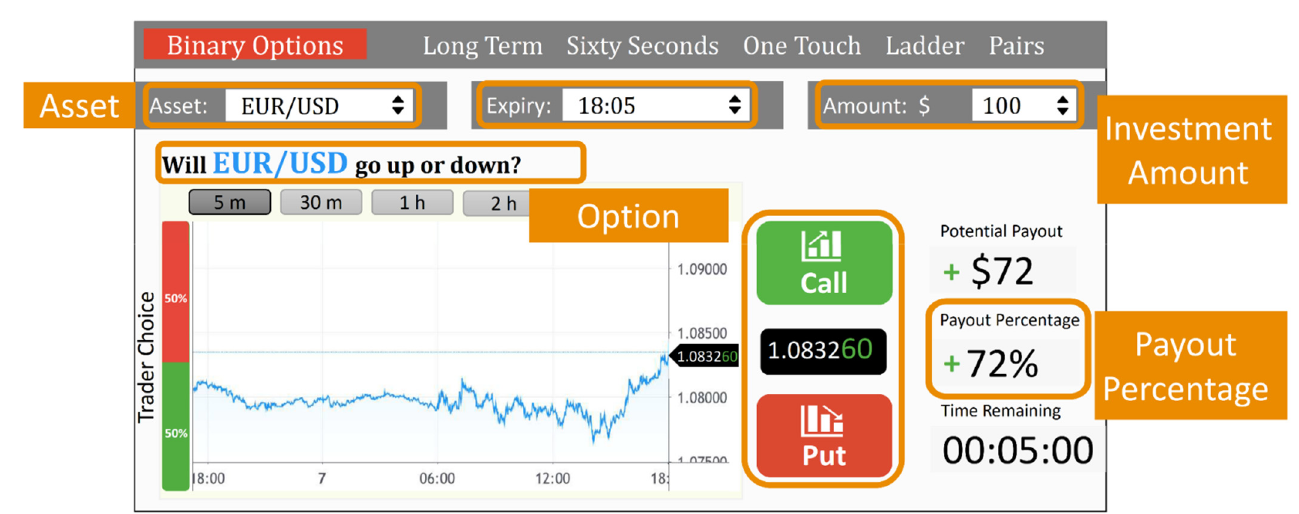
Figure 2. Components of typical user interface for binary options trading.